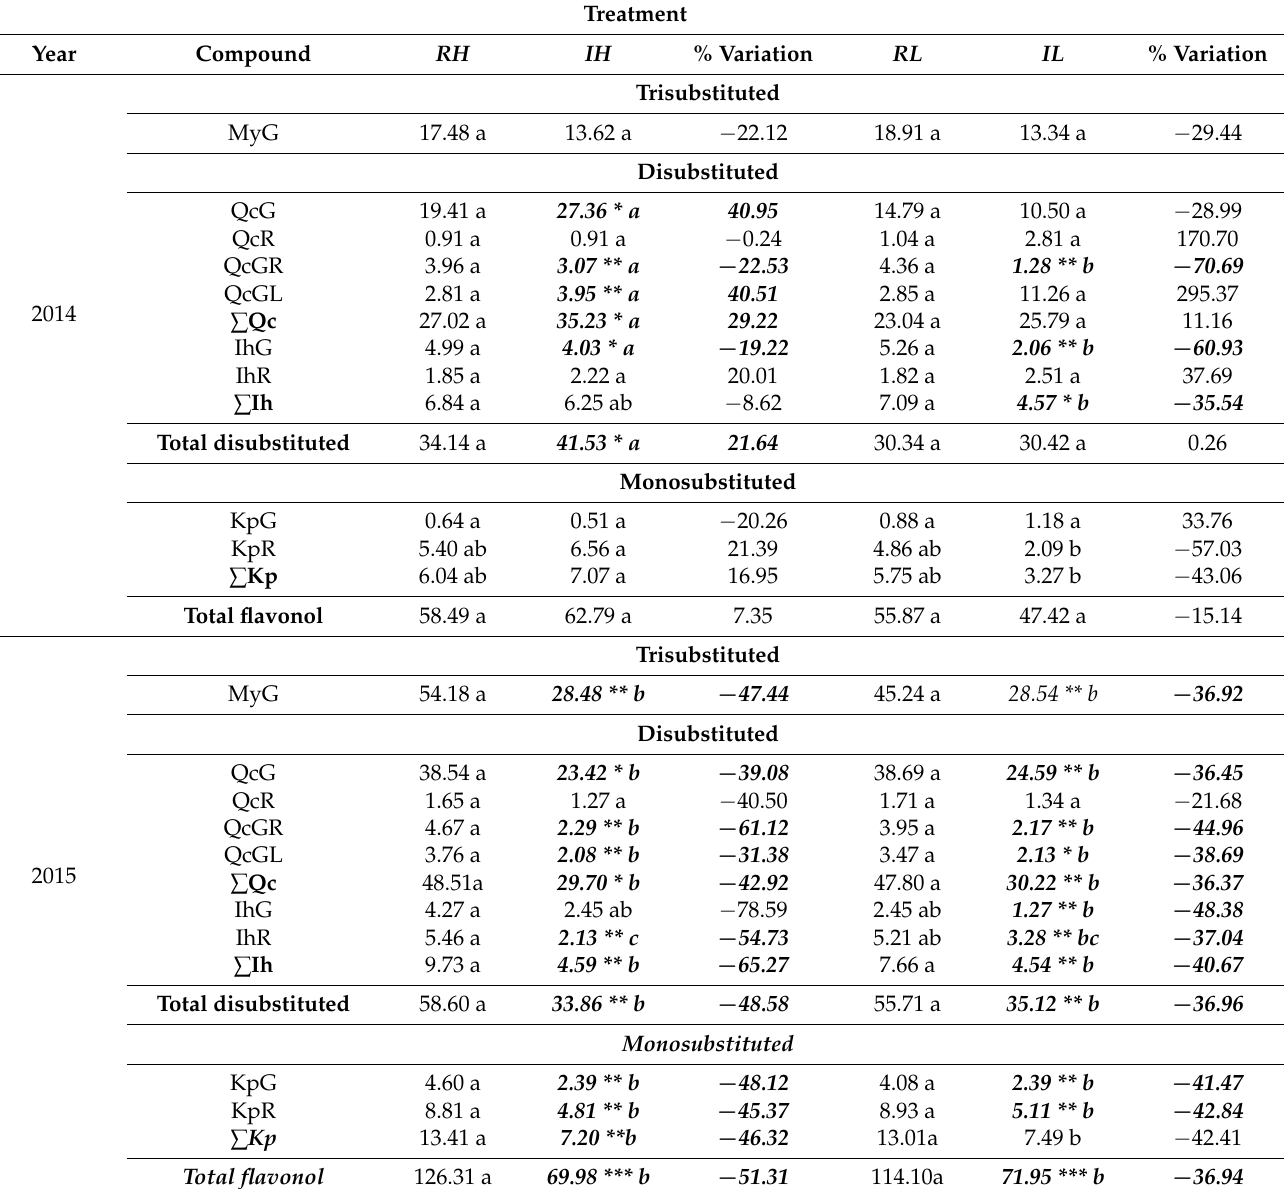
Table 5. Influence of irrigation on concentration of flavonol compounds (mg. kg − 1 berry